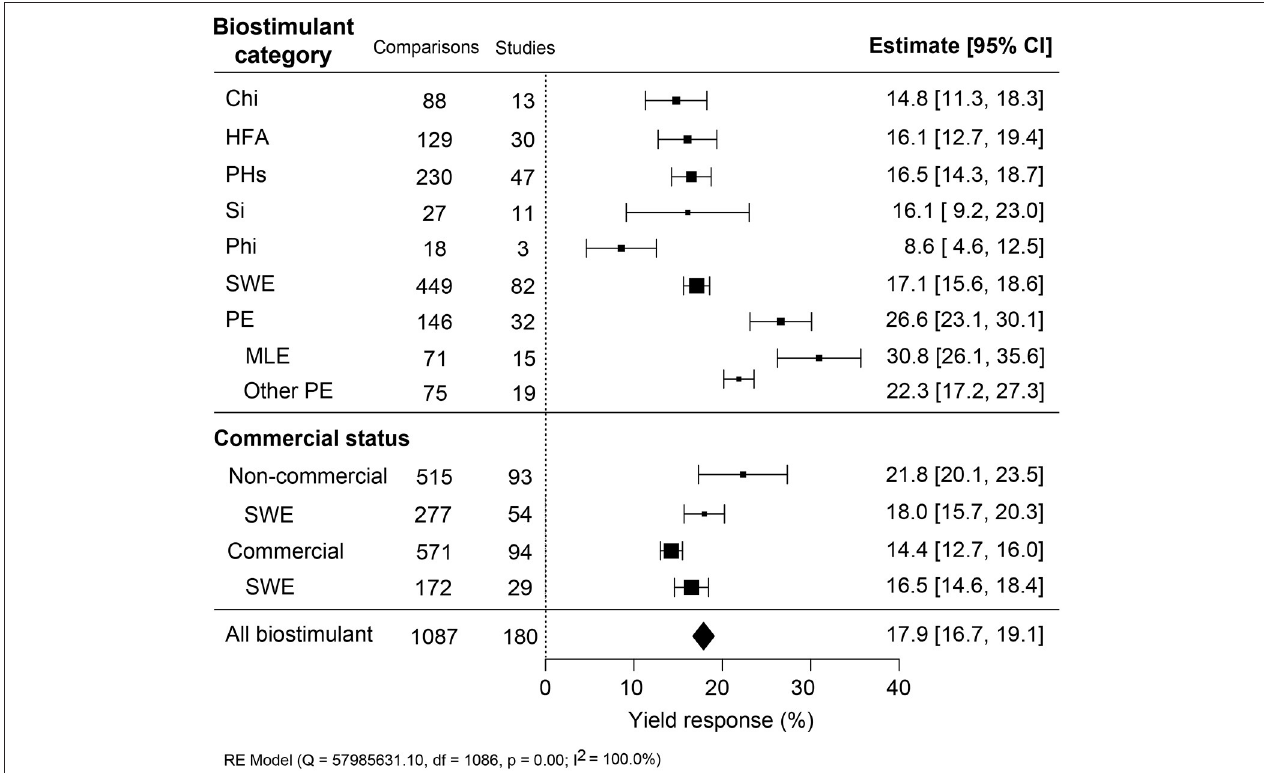
FIGURE 2 | Percentage yield response to biostimulant application affected by the biostimulant category and the commercial status of biostimulant products. The point size correlates to the estimate’s precision, and the error bars represent 95% confidence intervals (CI) of mean estimated effect sizes. The number of comparisons and studies is indicated in each line. The combined effect estimates and the heterogeneity test on the random-effect model (RE) are summarized at the bottom, where the heterogeneity test is significant ( p < 0.001) and I 2 ≥ 75% implies substantial heterogeneity. Chi, Chitosan; HFA, humic and fulvic acids; PHs, protein hydrolysates; Si, silicons; Phi, phosphite; SWE, seaweed extracts; PE, plant extracts; MLE, moringa leaf